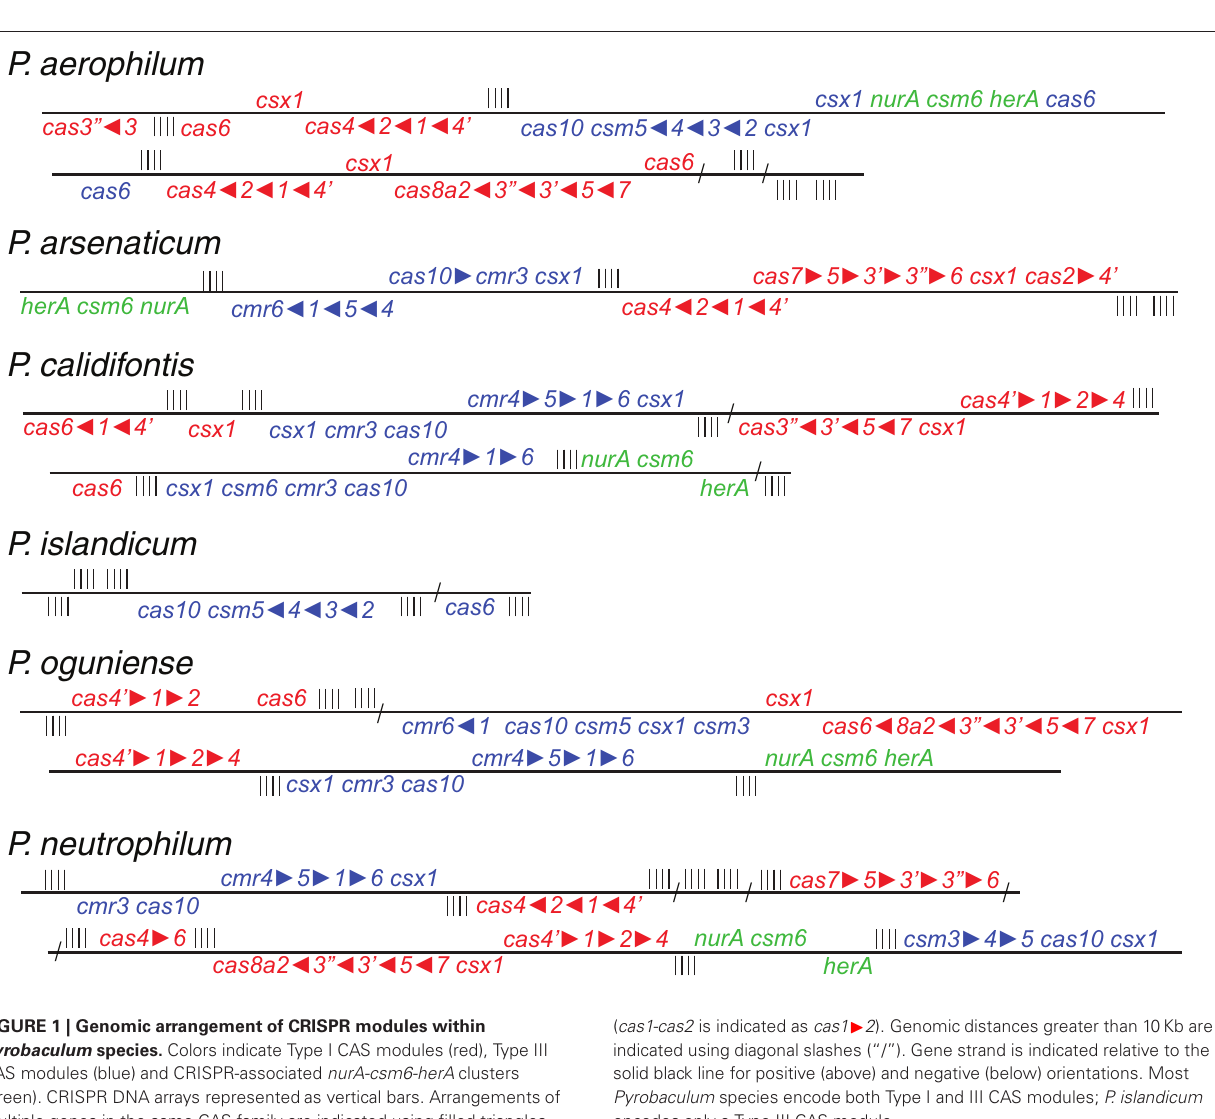
FIGURE 1 | Genomic arrangement of CRISPR modules within Pyrobaculum species. Colors indicate Type I CAS modules (red), Type III CAS modules (blue) and CRISPR-associated nurA-csm6-herA clusters (green). CRISPR DNA arrays represented as vertical bars. Arrangements of multiple genes in the same CAS family are indicated using filled triangles